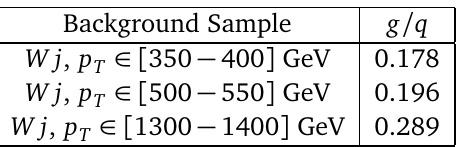
Table 1: Gluon to light quark ratios in the background